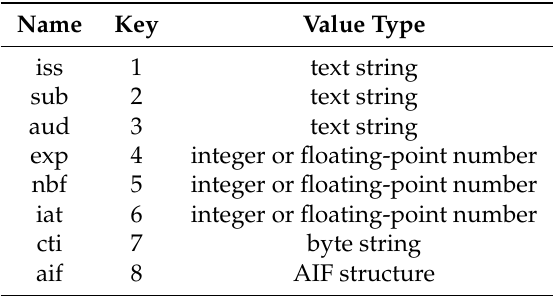
Table 2. Summary of the CWT+AIF